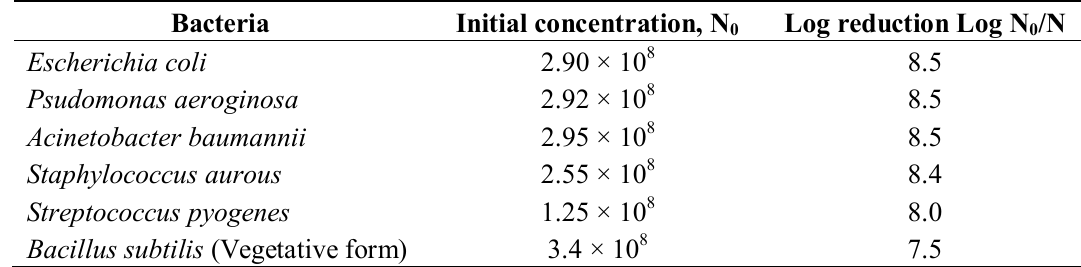
Table 1. Log reduction of bacteria in sterilized waste. Sterilization conditions: temperature 121 °C, time 60 minutes and pressure 15 psi.